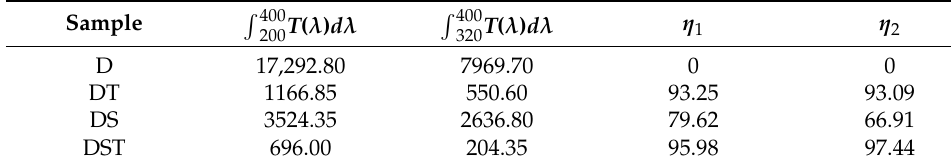
Table 3. UV shielding efficiency of the nanocomposite coatings.